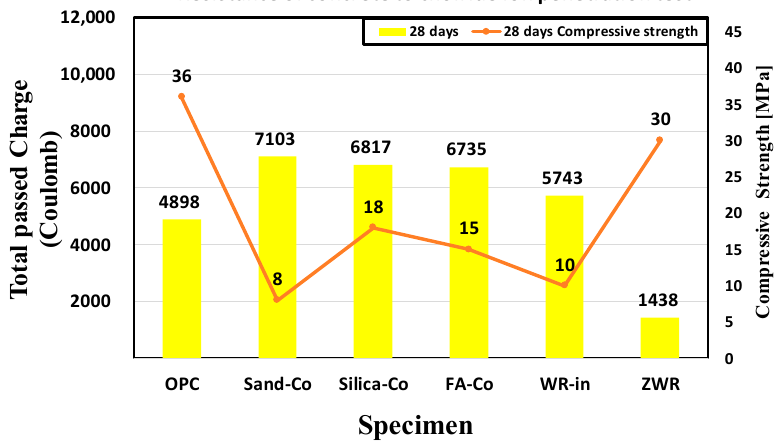
Figure 12. Result of resistance of concrete to chloride ion penetration test.